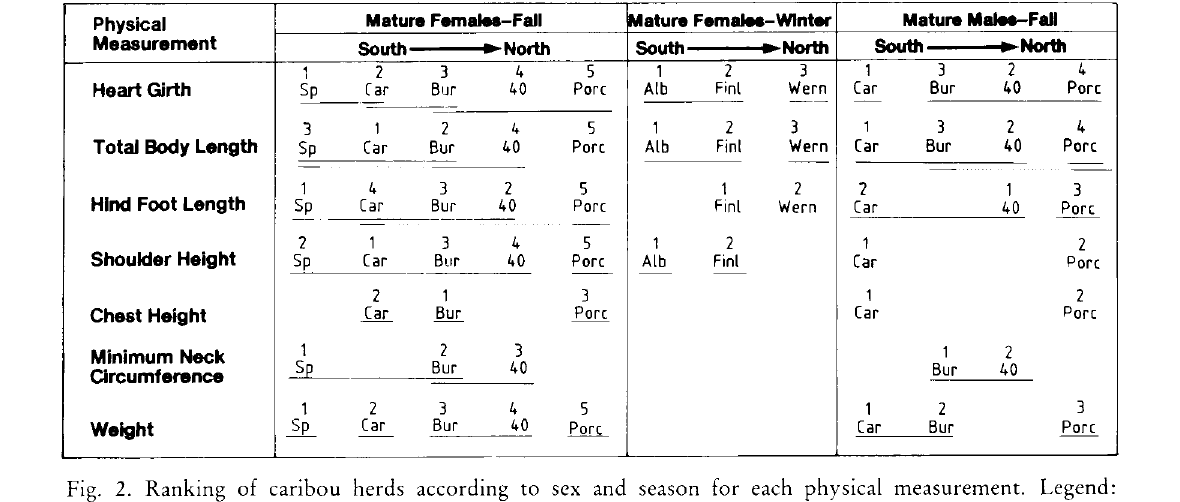
Fig. 2. Ranking of caribou herds according to sex and season for each physical measurement. Legend: Sp = Spatsizi, Car=Carcross, Bur=Burwash, 40 = Fortymile, Porc=Porcupine, Alb = Alberta, Finl = Finlayson, Wern=Wernecke.